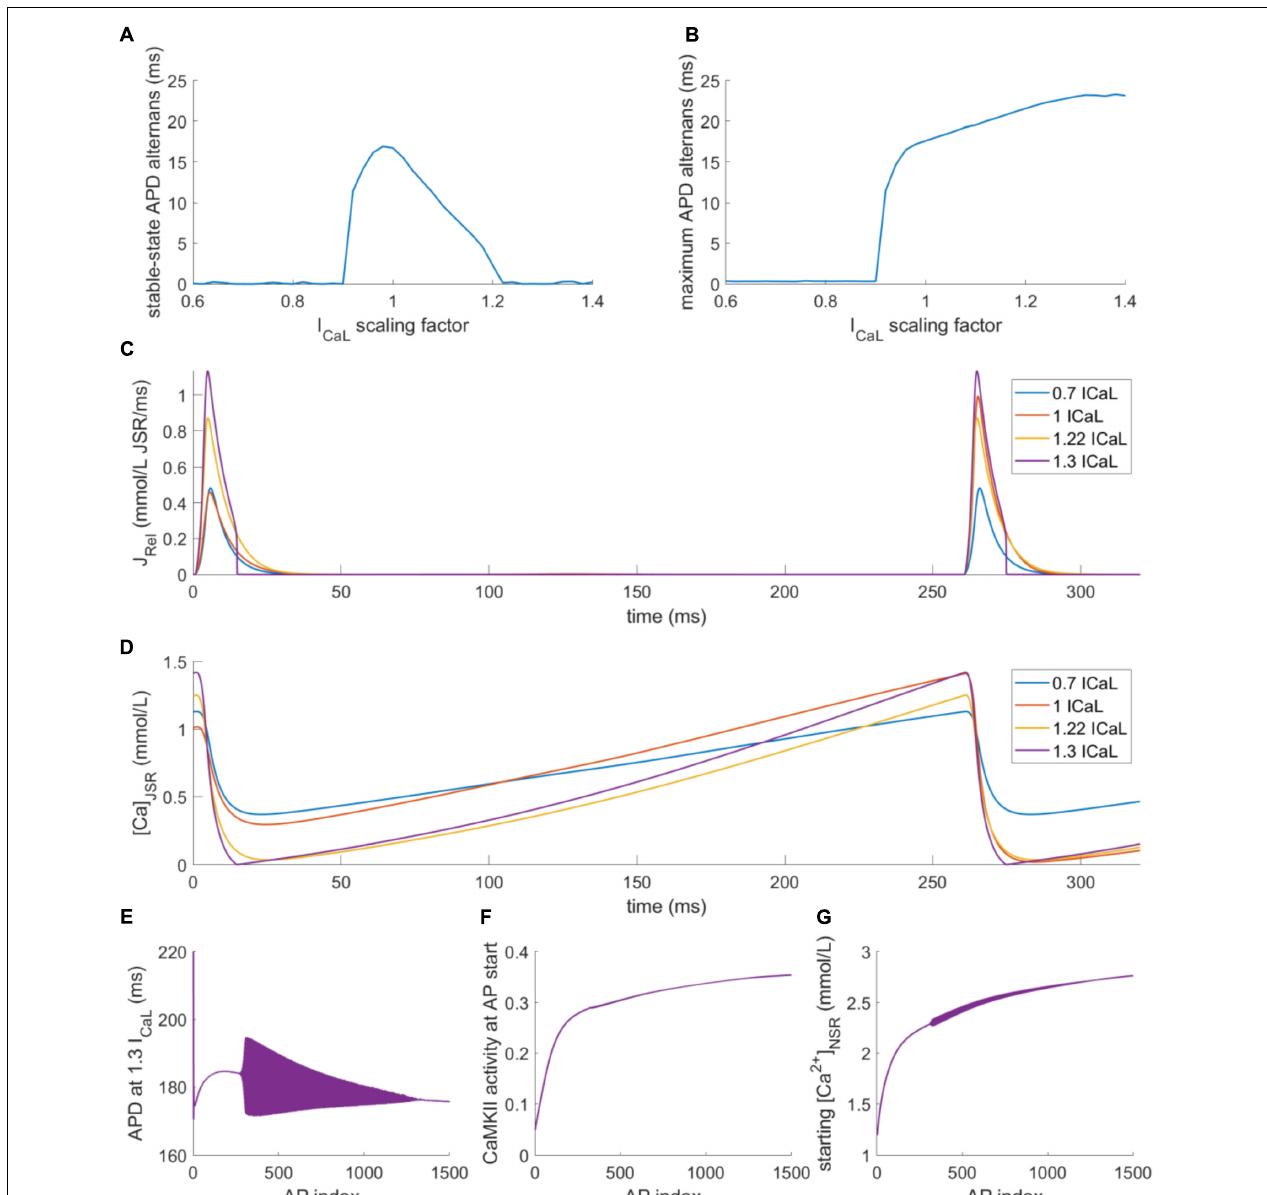
FIGURE 8 | Alternans at 260 ms bcl with varied I CaL conductance in the HeRd model. (A) APD alternans amplitude (difference in APD between last two APs) at the end of stable-state pre-pacing. (B) Maximum APD alternans (difference in two consecutive APs) at any stage between pre-pacing APs 30–2500 (first 30 APs were omitted as the model may manifest large APD changes at the start of the simulations, which are not due to alternans). (C) Examples of J rel for four I CaL scaling factors after stable-state pre-pacing, showing alternans for I CaL scaling factor of 0.7 and 1 but not for 1.22 or 1.3; (D) JSR calcium levels aligned with the plot (C), showing full depletion in both beats at calcium scaling factors of 1.22 and 1.3. (E) Development of APD during pre-pacing for I CaL scaling factor of 1.3, the filled area represents alternans of APD; first 1500 beats of pre-pacing shown. (F) Increasing CaMKII activity during pre-pacing for I CaL scaling factor of 1.3. (G) Increasing NSR loading during pre-pacing of the model with I CaL scaling factor of 1.3, measured as NSR calcium at the start of an action